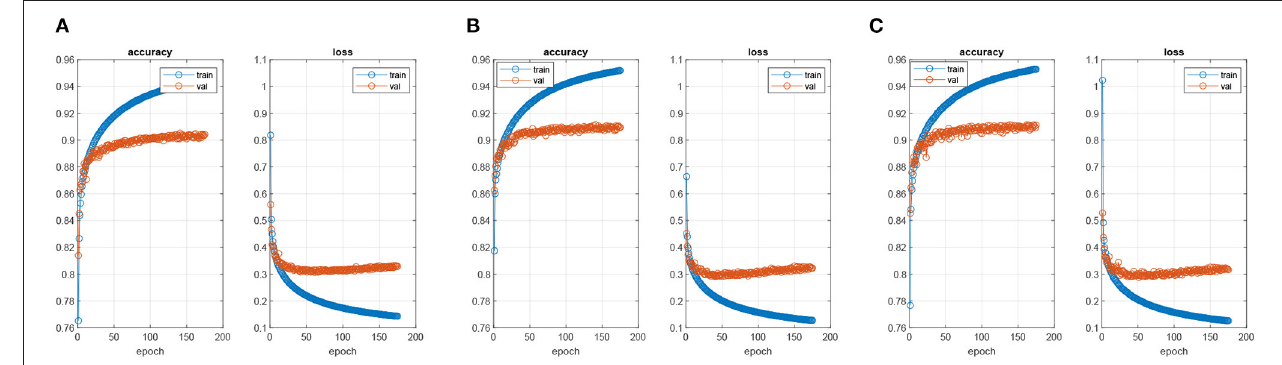
FIGURE 5 | The process of training FCN models. (A) FNC-32s model, (B) FNC-16s model, and (C) FNC-8s